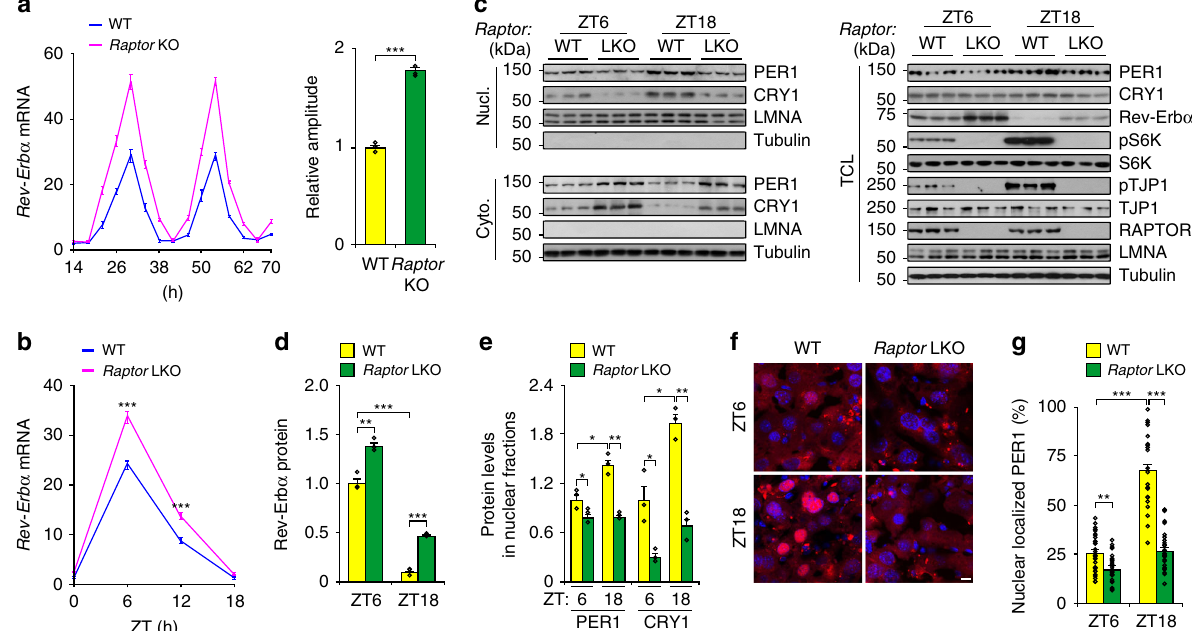
Fig. 4 mTOR dampens hepatic circadian amplitude. a Relative mRNA level of Rev-Erb α (left panel) and rhythmic amplitude (right panel) in wildtype (WT) or Raptor LKO mouse primary hepatocytes cultured in a collagen sandwich con fi guration. Hepatocytes were exposed to dexamethasone (0.1 μ M) and then harvested at different time points. n = 6. b Effect of Raptor LKO on Rev-Erb α expression in the liver from mice at ZT6 and ZT18. n = 4 – 7 mice. c – e Effect of Raptor LKO on cellular localization of PER1 in the liver evaluated by immunoblots c , and statistical analysis of Rev-Erb α in TCL d , and PER1 and CRY1 in Nucl. e from immunoblots as shown in c . n = 4 – 7 mice. f and g Effect of Raptor LKO on cellular localization of PER1 in the liver visualized by mCherry-PER1 f and statistical analysis of the results g . n = 4 – 7 mice. Scale bar, 10 μ m. Data are shown as mean ± s.e.m. Comparison of different groups was carried out